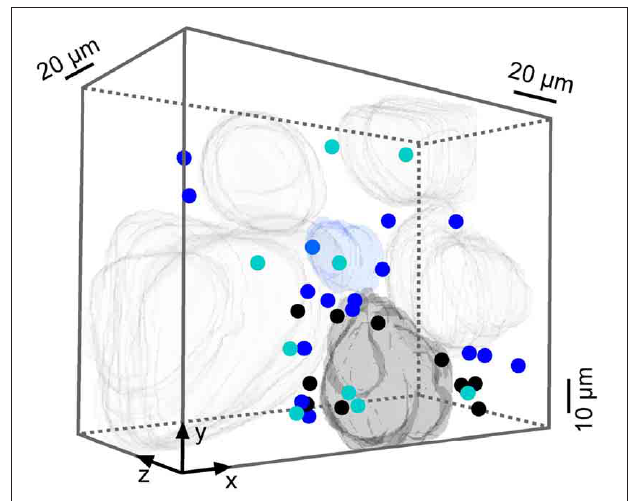
FIGURE A7 | INHIBITED neurons responding to both odorants. 3-D volume reconstruction showing cells and glomeruli inhibited by isoamyl acetate (cyan), 2-hexanone (blue), or both (dark